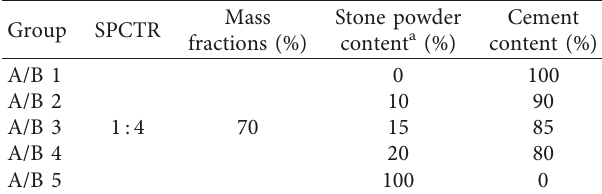
Table 3: Backfilling slurry of stone powder cement tailings ratio (SPCTR), mass fractions, stone powder content, and cement content.